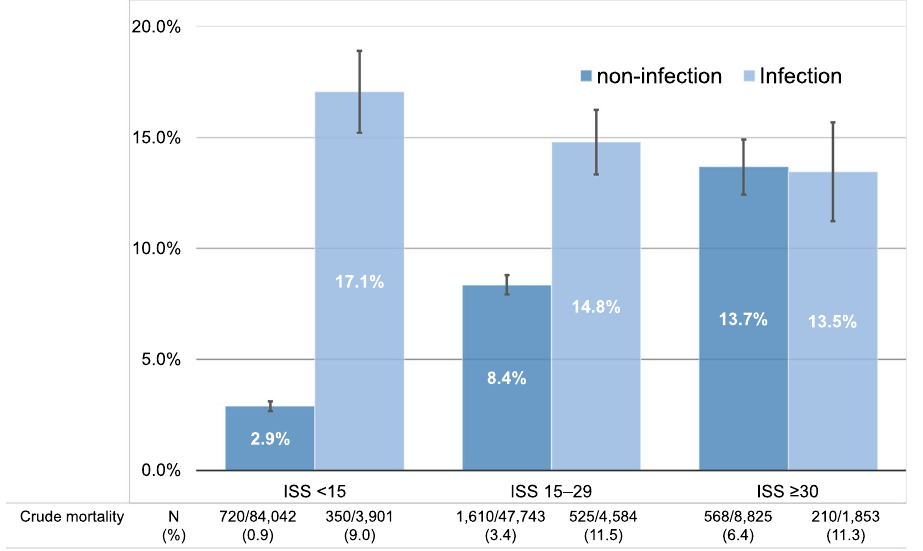
Figure 2. Crude and adjusted in-hospital mortality in patients with and without infection by trauma severity. The crude mortalities are summarized in the table and adjusted mortalities and its 95% confidence interval calculated by the multivariable logistic regression analysis are demonstrated with a bar graph with error bars. ISS Injury Severity